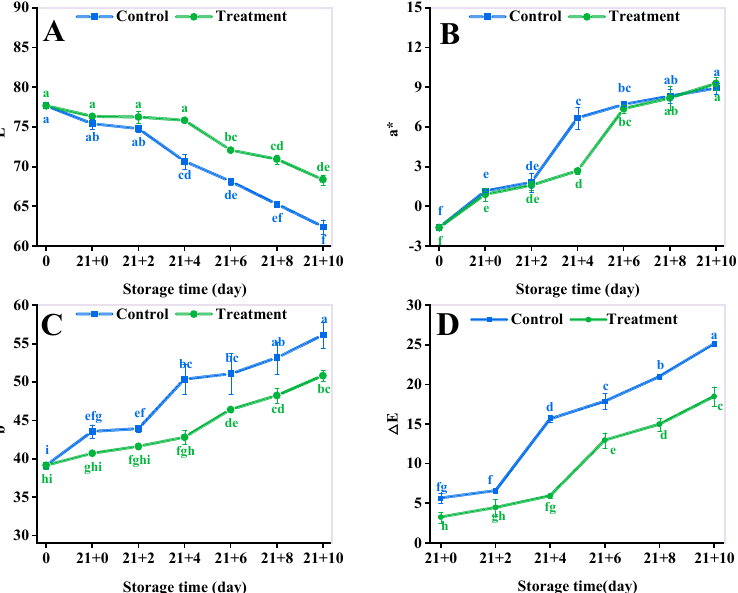
Figure 1. Effect of different storage methods on the L* ( A ), a* ( B ), b* ( C ), and ∆ E* ( D ) of yellow peaches. Vertical bars represent standard deviations. Different letters represent statistical differences ( p < 0.05).